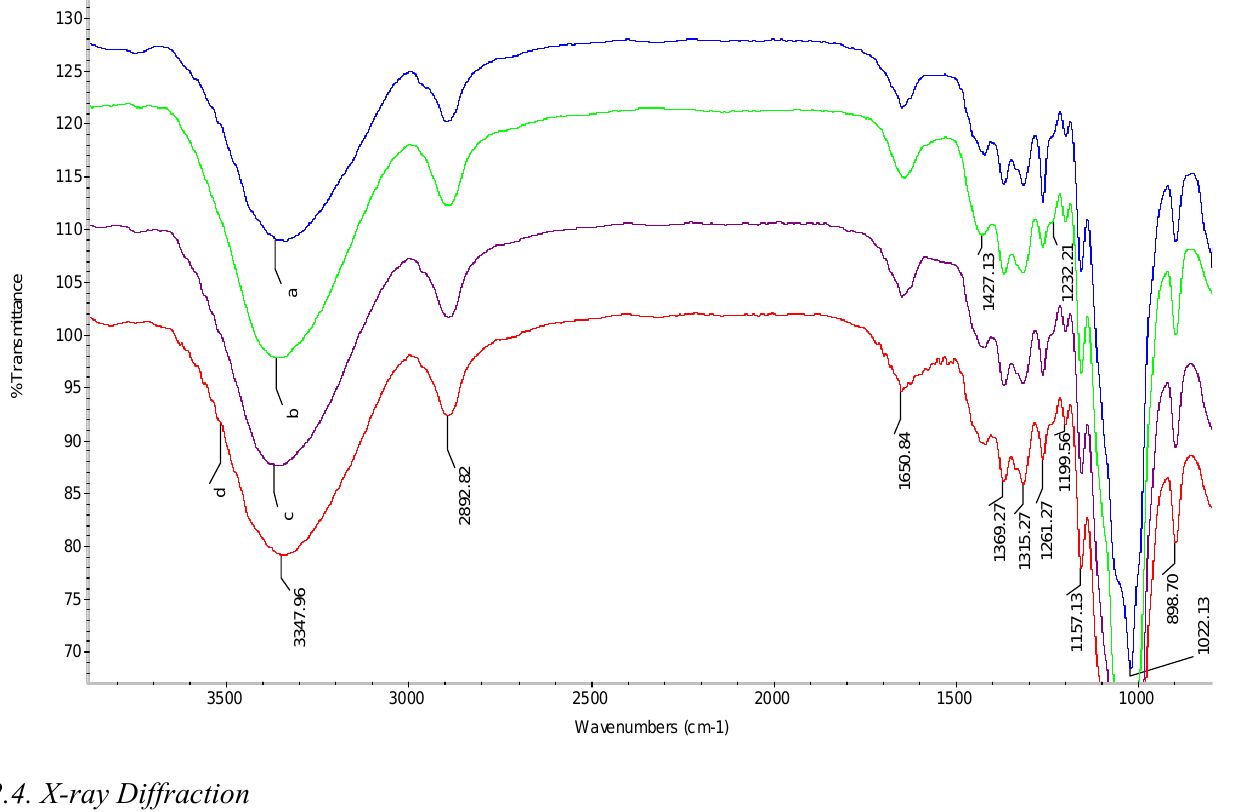
Figure 3. The FTIR spectra of cellulose films: ( a ) control sample; ( b ) cellulose film plasticized with sorbitol; ( c ) cellulose film plasticized with glycerol; ( d ) cellulose film plasticized with